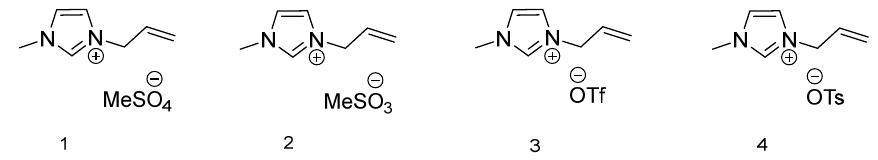
Figure 1. Structures of ionic liquids based on 1-allyl-3-methylimidazolium cation.